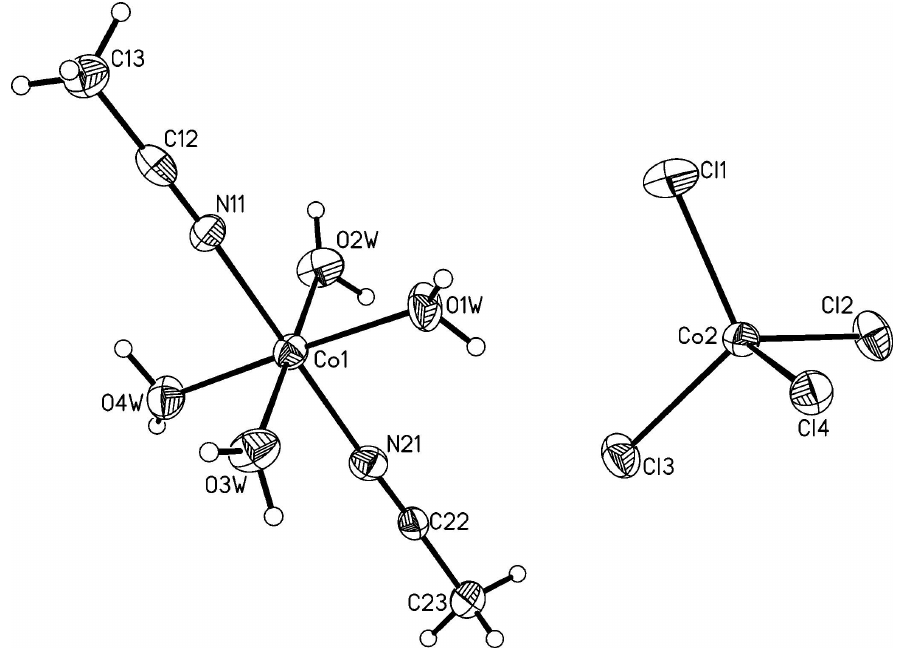
Figure 1 Anisotropic ellipsoid representation of compound I with atom labelling scheme (Siemens, 1989). The ellipsoids are drawn at the 50% probability level, hydrogen atoms are depicted as spheres of arbitrary radii. Hydrogen bonds are drawn as dashed